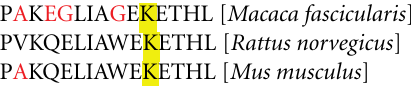
et al., 2012b), this implies that GAT1 and GAT3 are the